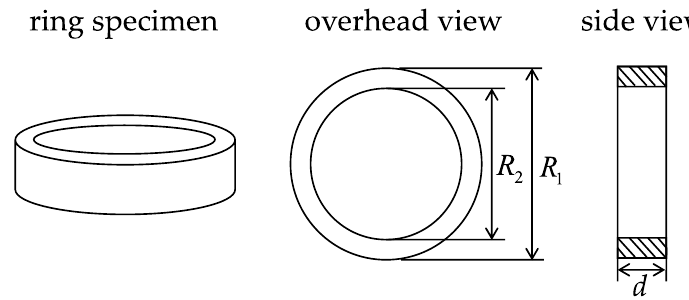
Figure 1. The overhead view and side view of the ring specimen.